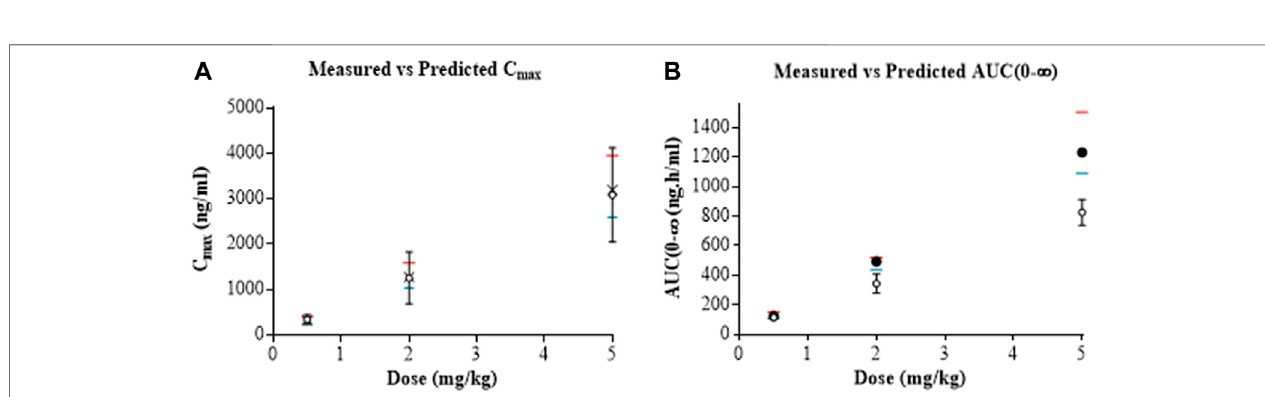
FIGURE 3 | Predicted mean (closed circles) and CI95% (crosses) versus observed (open circles) C max (A) and AUC (0- ∞ ) (B) of homosalate after IV doses of 0.5, 2 and 5 mg/ kg to rats. Predictions were generated using optimized input values. The CI95% (red lines) and CI5% (blue lines) are also included.